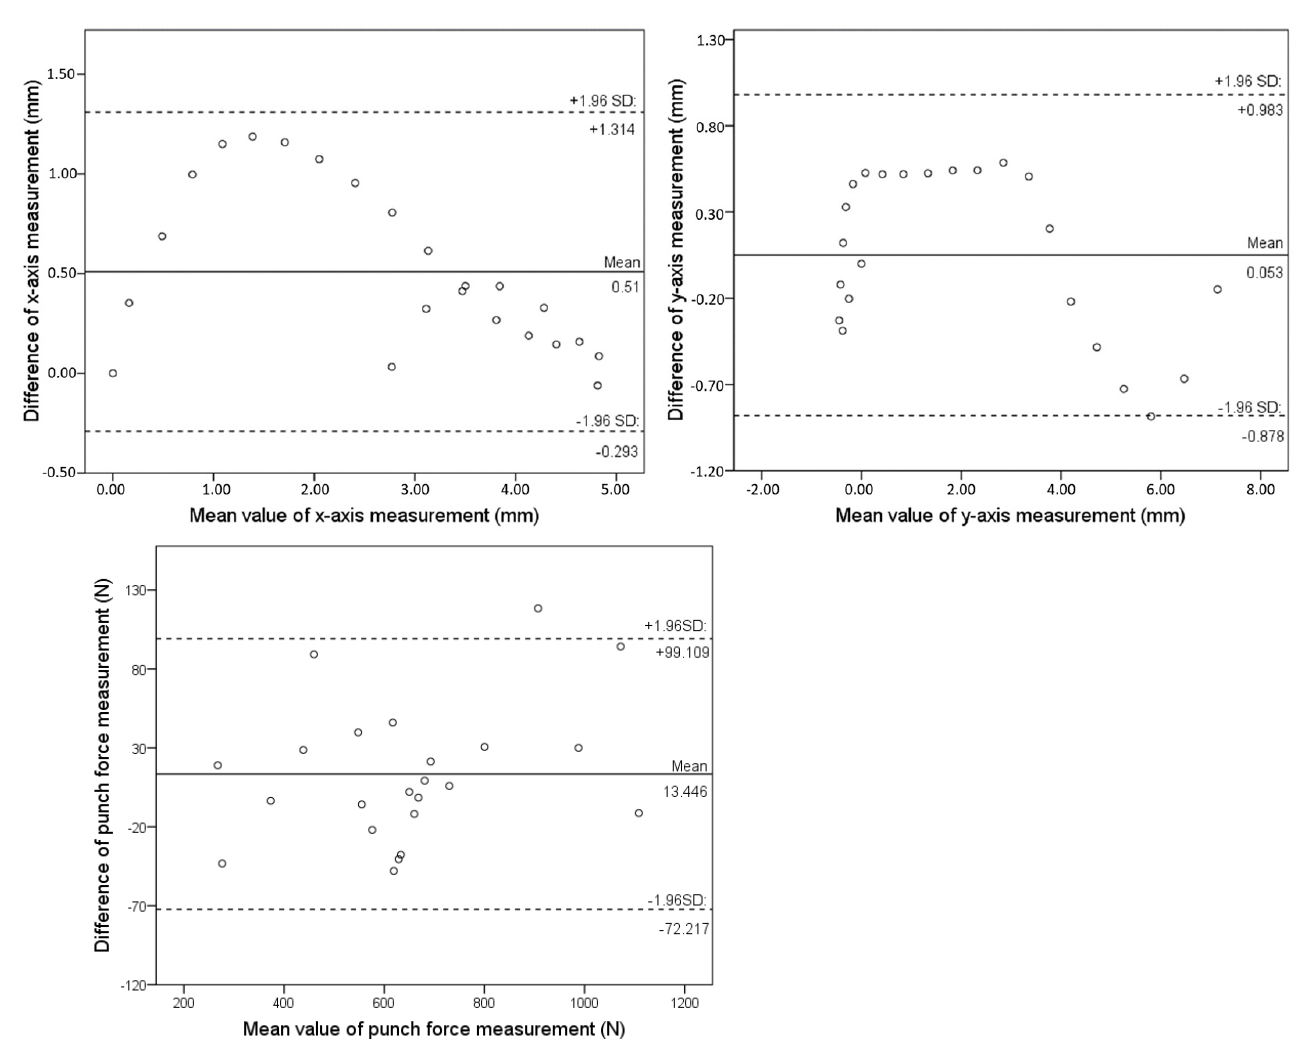
Figure 5. Bland–Altman analysis for force plate vs. developed sensor system example test run.